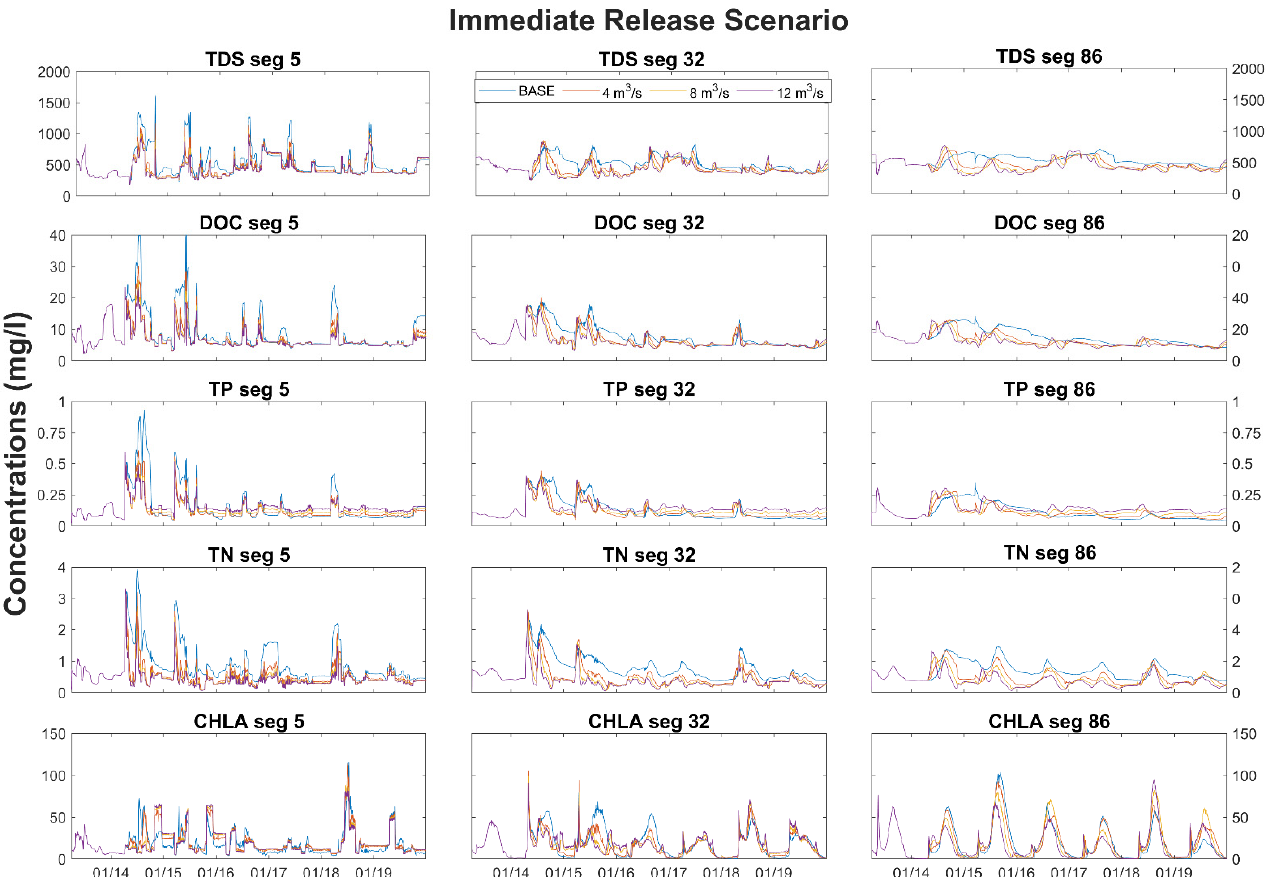
Figure 6. Output for five model-derived water quality constituents of interest at segments 5, 32 and 86 for the immediate release